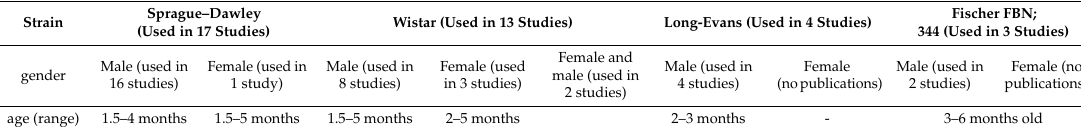
Table 1. Rat strain, gender, and age.